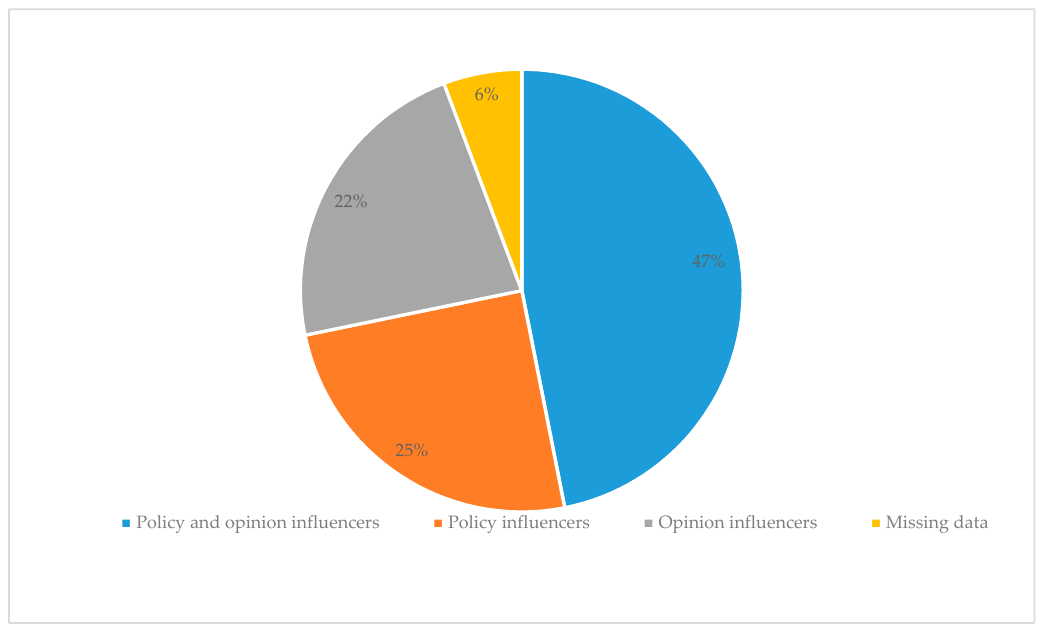
Figure 3. Indicated reason to nominate a peer.